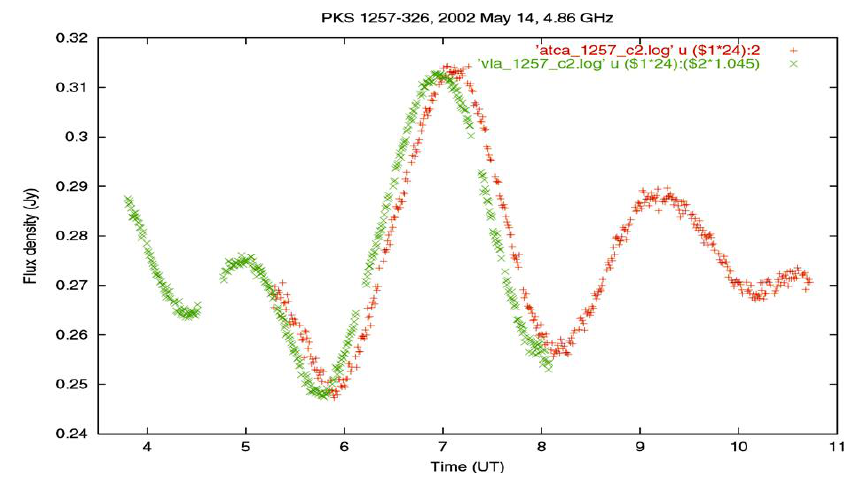
Figure 5. The time delay at 4.86 GHz between the ATCA and the VLA 14 May 2002 [25]. Reproduced with